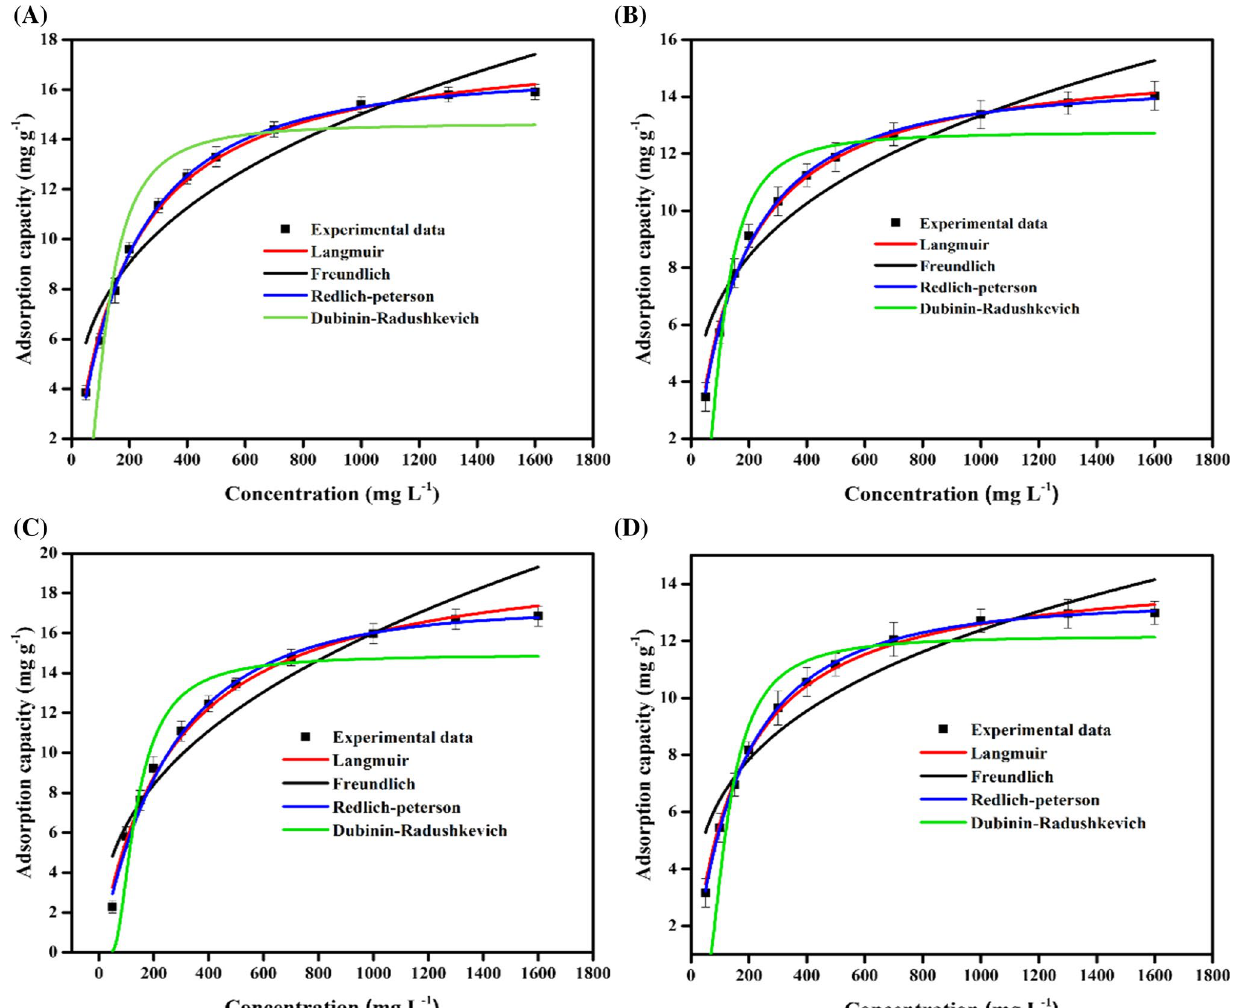
Fig. 5 Adsorption isotherms of DR5B ( a ), DB22 ( b ), DB71 ( c ), and RB5 ( d ) for the adsorption onto spent mushroom